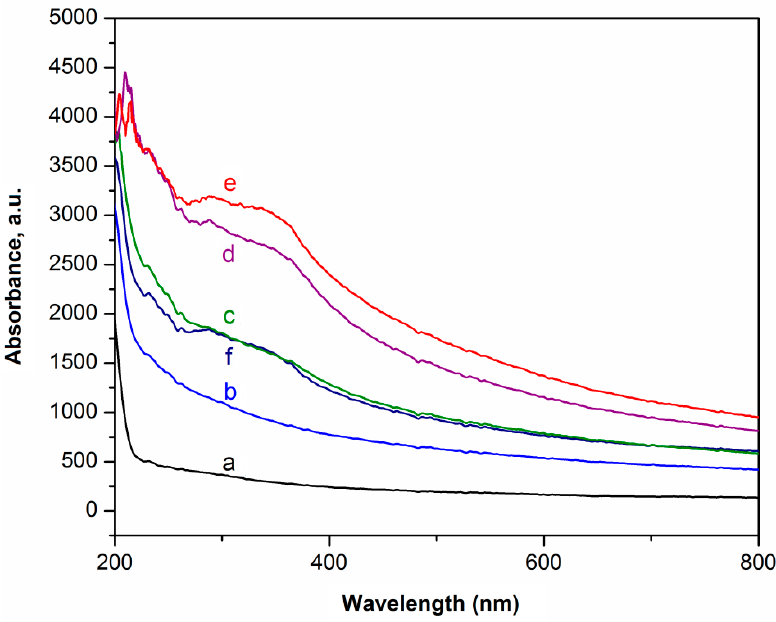
Figure 8. UV–Vis spectra of LDPE-based composite films: ( a ) pristine LDPE, ( b ) LDPE/MgO, ( c